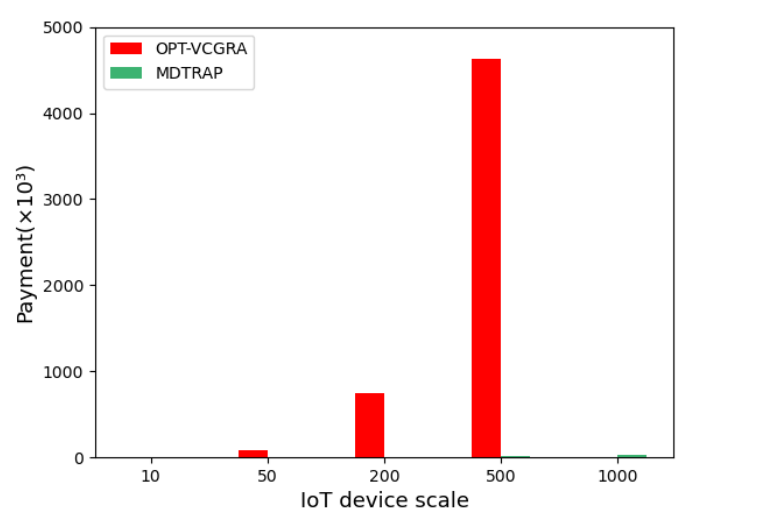
Figure 6. The total amount paid by the VSP to IoT devices under different numbers of IoT